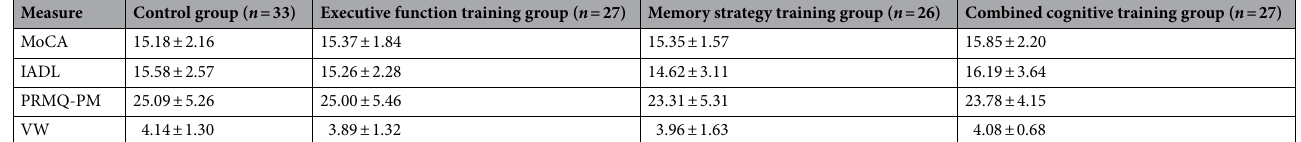
Table 2. Baseline levels of the participants before intervention (mean [ M ] ± standard deviation [ SD ]). MoCA montreal cognitive assessment scale, IADL instrumental activities of daily living scale, PRMQ‑PM prospective and retrospective memory questionnaire-prospective memory, VW virtual week task.